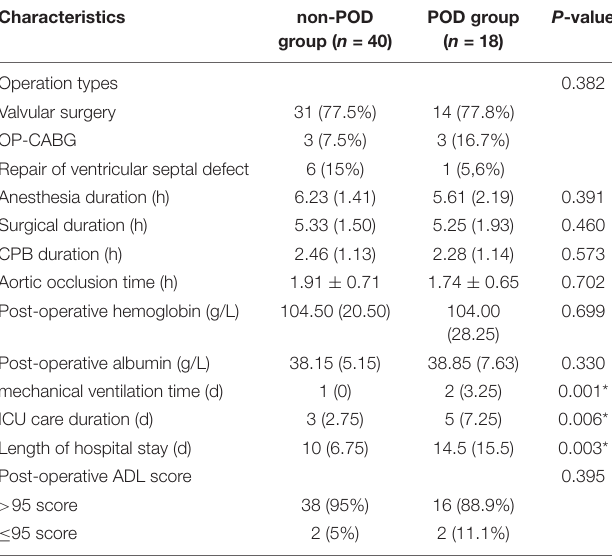
TABLE 2 | Anesthesia and surgical data of the non-POD group and POD group.